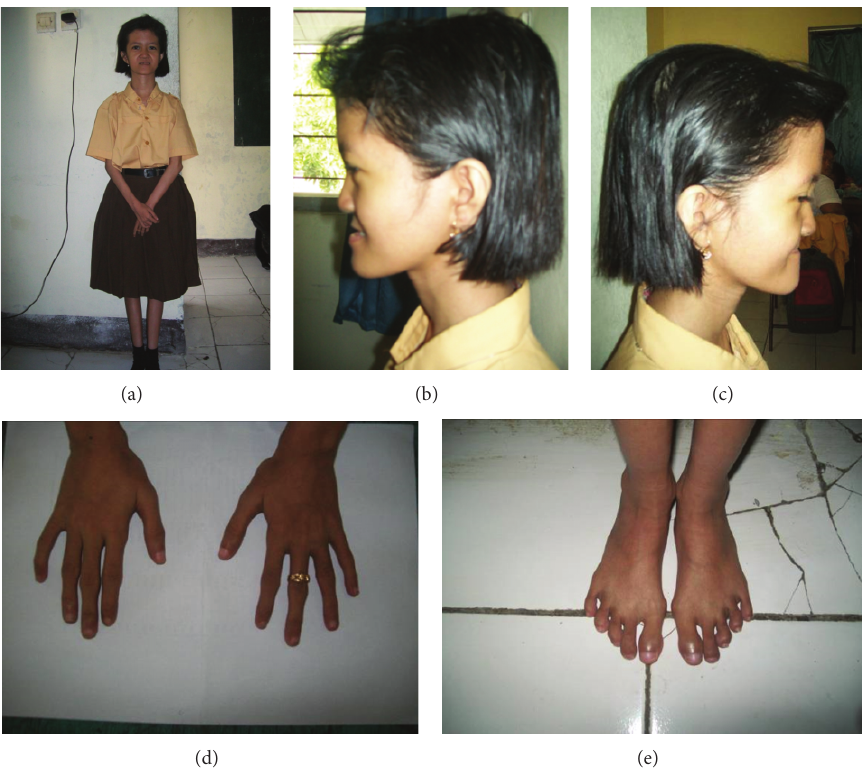
Figure 1: Photograph of Indonesian patient with a 14q32.2 microdeletion. Our 20-year-old patient showed extremely short and thin stature, flat face, flat philtrum, thin lips, tapering fingers, clinodactyly of the fifth finger on the right hand, and clubbing feet